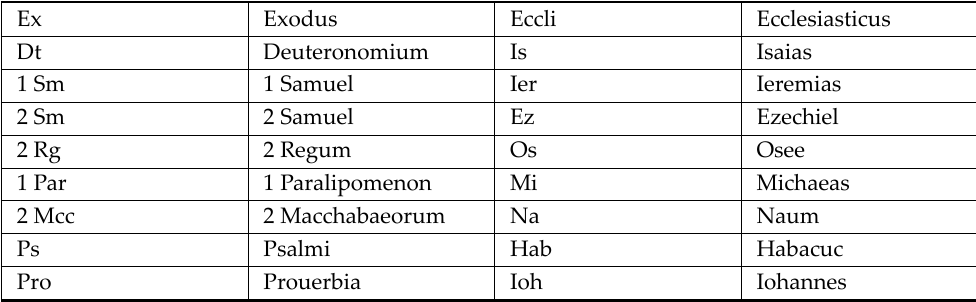
Table A3. Biblical